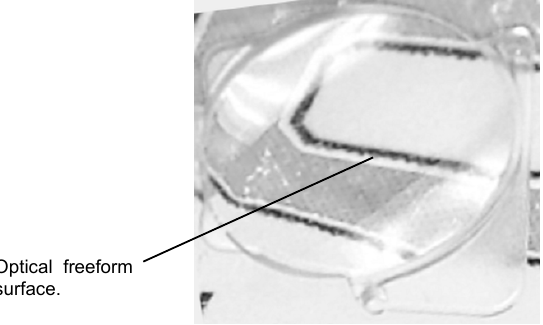
Figure 1. Freeform lens manufactured by the µIM process.